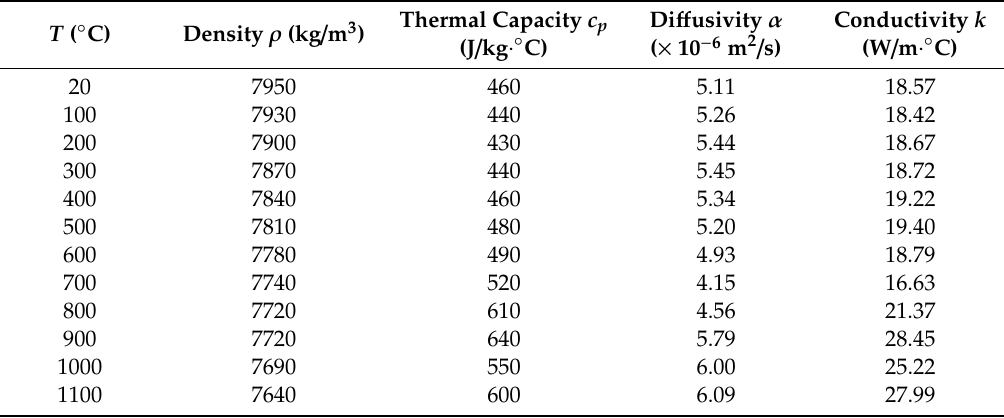
Table A1. Thermophysical properties for M4 HSS material obtained by DED